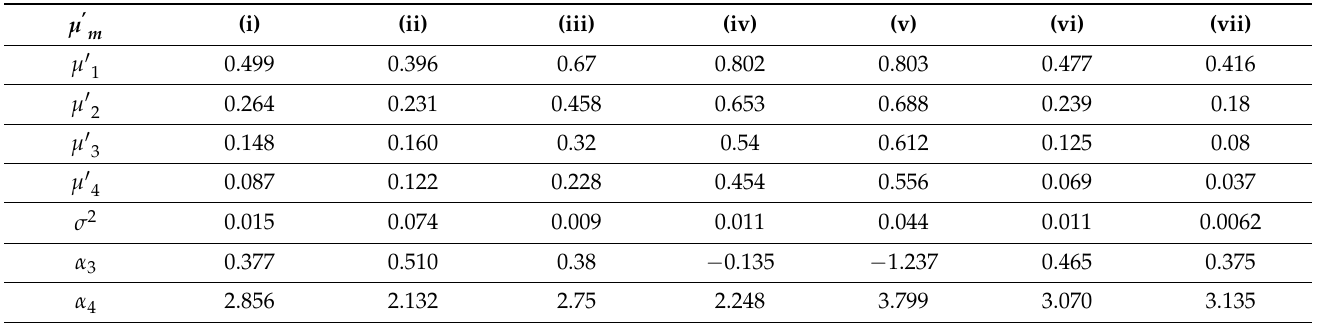
Table 1. Several UPBXD moment